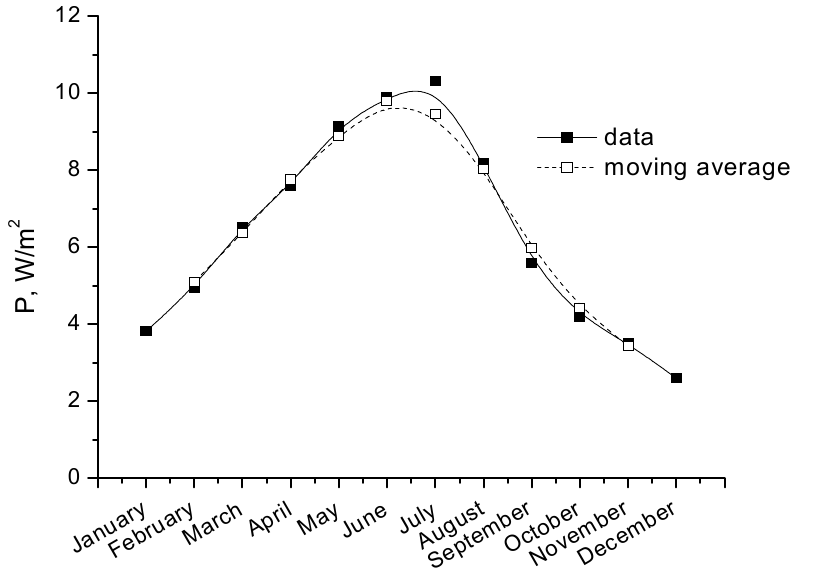
Figure 6. Comparison between weekly moving average data and the mathematical model.